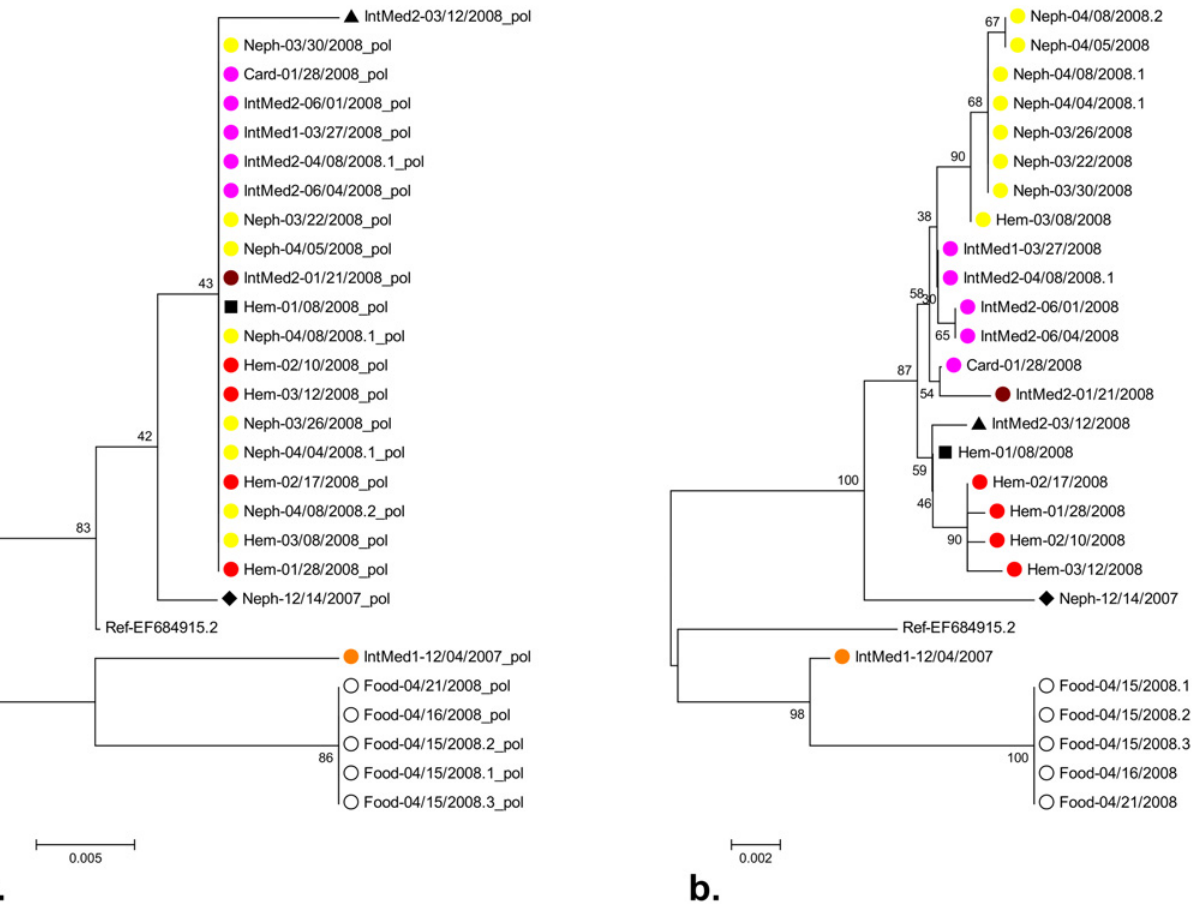
Figure 4. Comparative phylogenetic analysis of polymerase (a.) and capsid (b.) gene sequences. Neighbor Joining trees based on polymerase sequences (a., 226 – 285 nt) and capsid sequences (b., 1412 nt) of 27 samples from which both sequences were available are shown. Color labels indicate clustering according to the phylogenetic analysis of all capsid sequences shown in Fig. 1 (cluster 1: pink, cluster 2: yellow, cluster 3: brown, cluster 4: red, cluster 5: orange, foodborne cluster 7: empty black circle, singleton 2: black triangle, singleton 3: black square, singleton 4: black diamond.